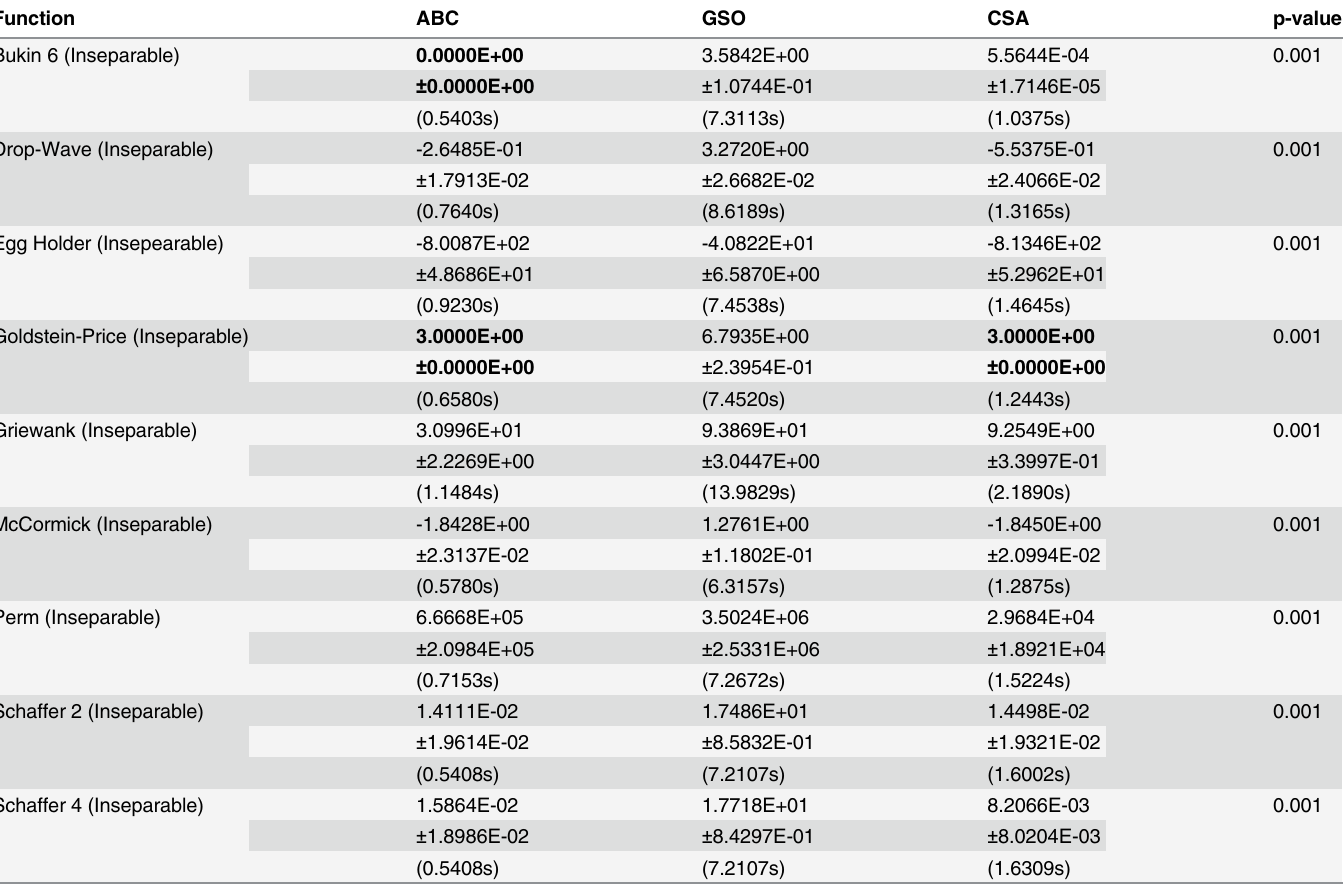
Table 8. Benchmark Functions Comparison of mean error (Mean ± SD) and time (Seconds) on Several Optimization Techniques.